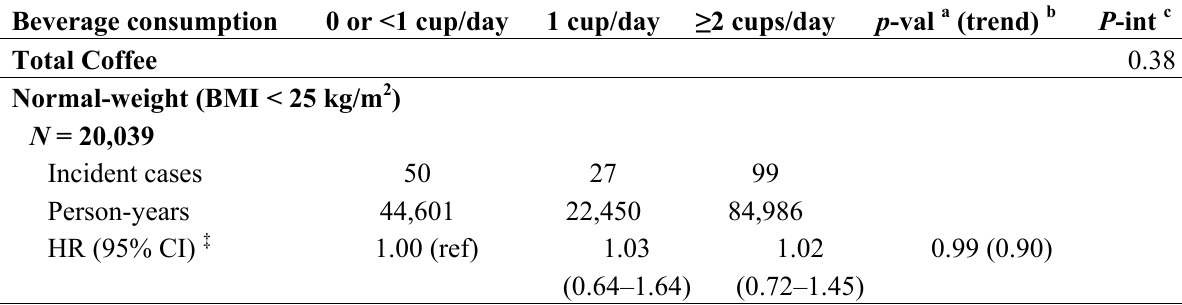
Table 3. Multivariable HRs and 95% CIs of total coffee, caffeinated coffee and decaffeinated coffee consumption in relation to endometrial cancer by body mass index status in the Women’s Health Initiative Observational Study ( N =